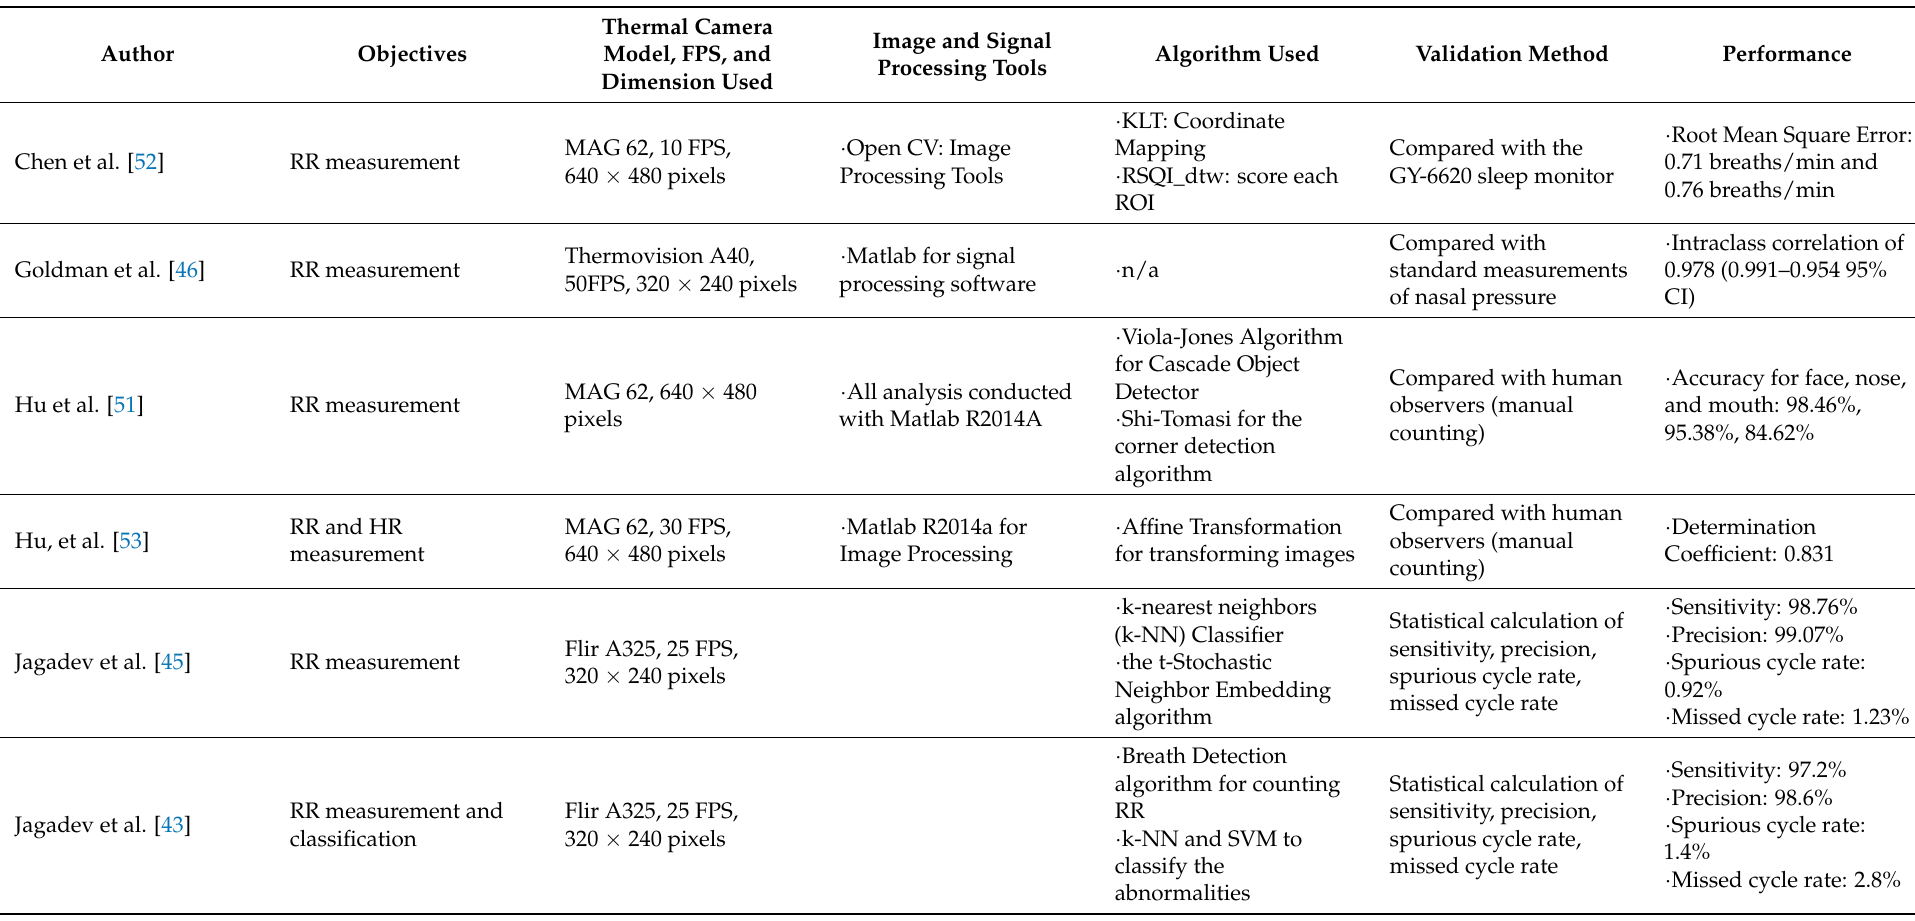
Table 3. Summary of Thermal Camera Usage Related to